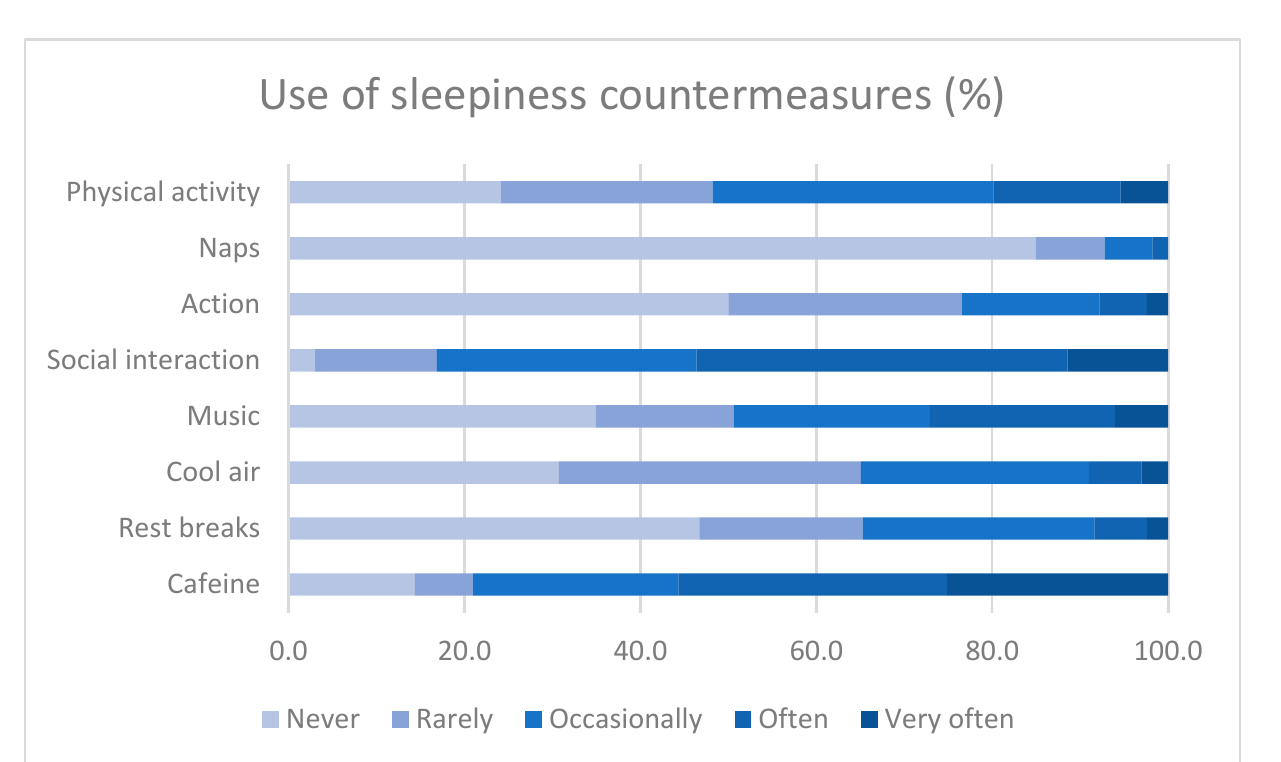
Figure 3. Frequency distribution for the perceived efficiency of sleepiness countermeasures. 3.5. Other Strategies in Case of Severe Sleepiness Only 9% of the respondents have ever asked not to take a shift due to severe fatigue. When they feel sleepy on the bridge, 76.5% do not ask to be replaced, 15.3% do so rarely,